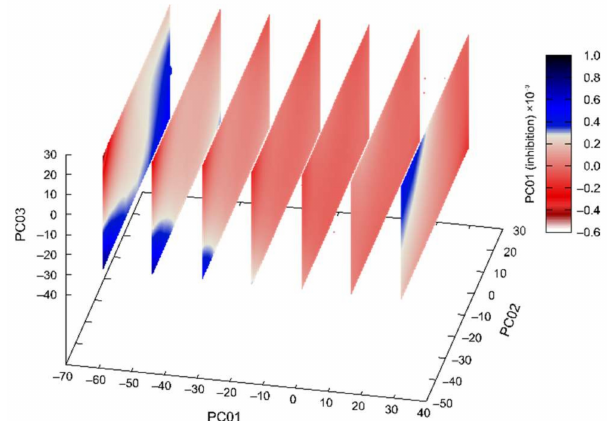
Figure 4. Machine learning determined the best multivariate regression model for fluorinated CD - derivatives inhibition of AChE and BChE in dependence on the first three principal components of compounds’ potential energy surfaces. (Spheres represent points in 3D reduced space, and the planes are cuts of the calculated polynomial regression model, for easier interpretation 4th-dimension is represented redundantly with the color and with the size of the spheres.).